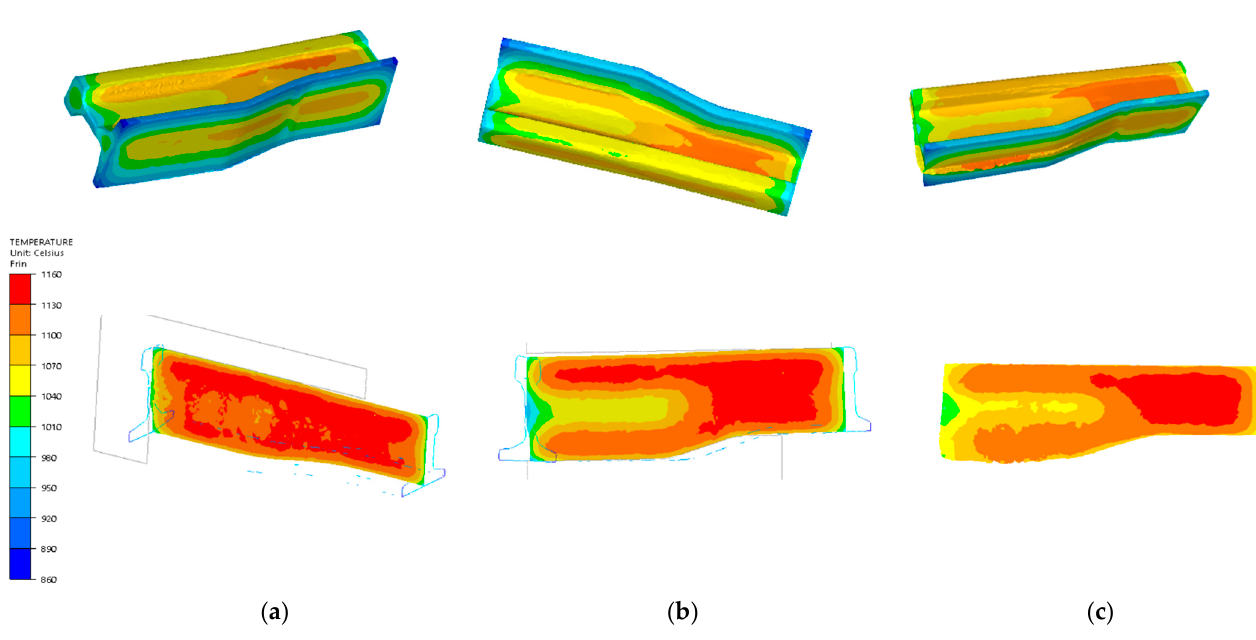
Figure 17. The temperature distribution after the consecutive forging operations: ( a ) after operation I, ( b ) after operation II, ( c ) after operation III; the lower results are for the cross sections of the reforged rails.